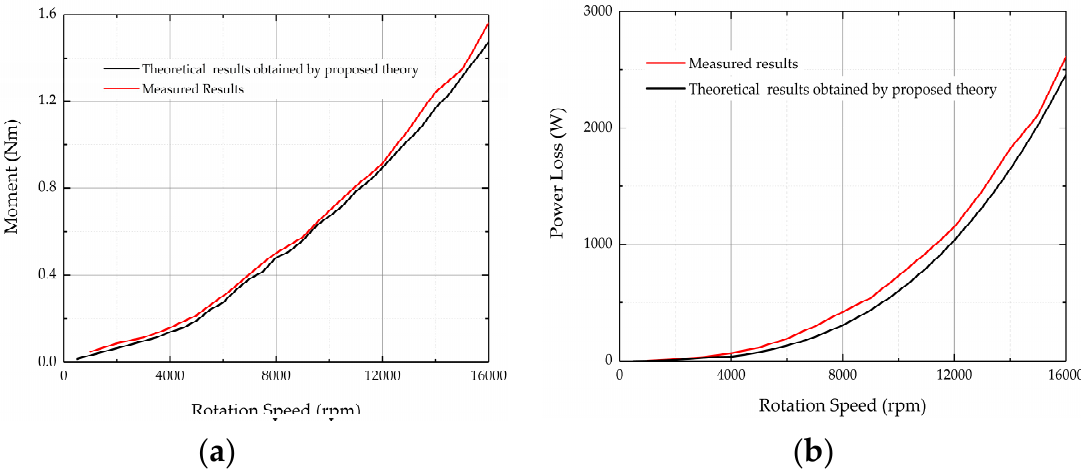
Figure 9. Comparison of theoretical calculation and experimental test of motor loss. ( a ) Motor rotor torque loss diagram. ( b ) Motor power loss diagram .